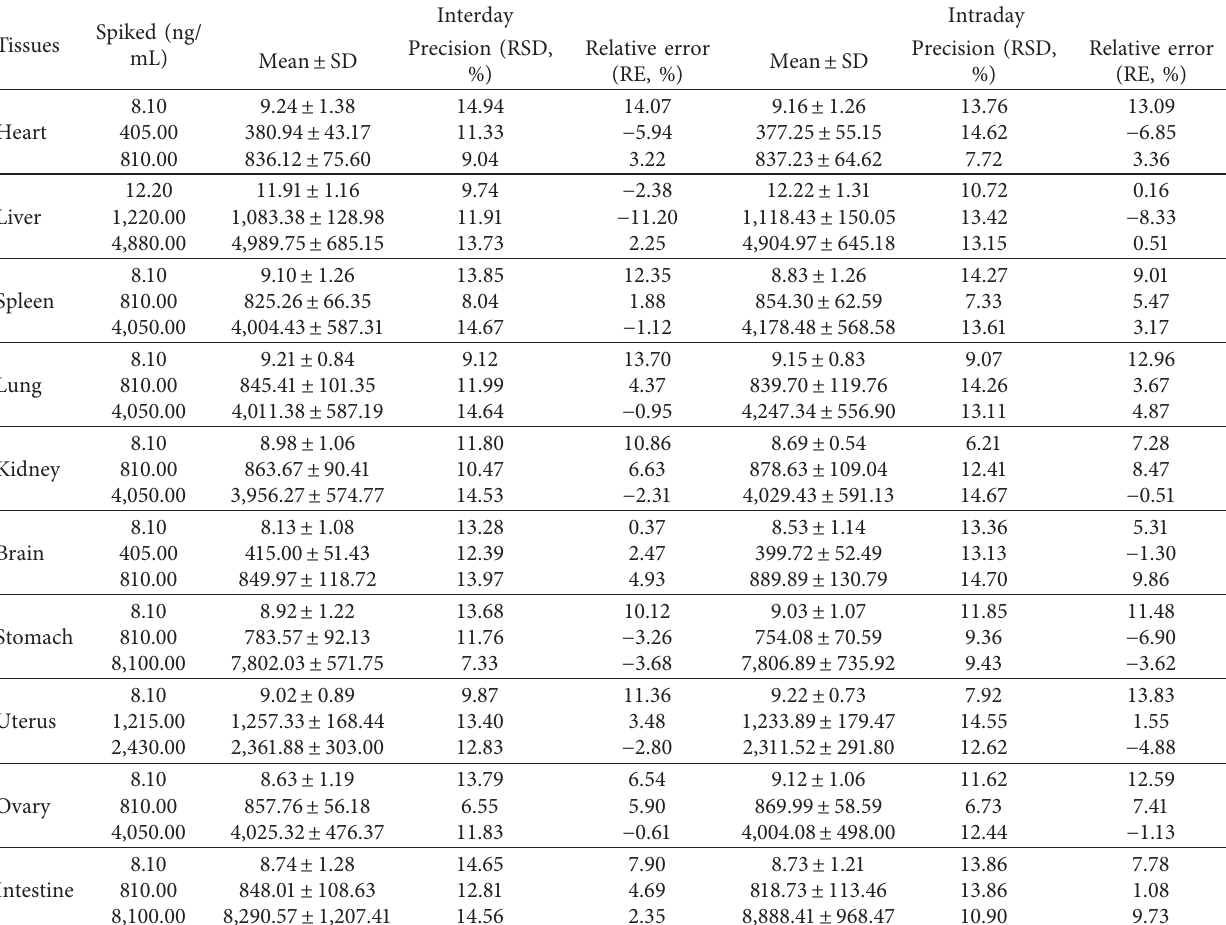
Table 6: Interday and intraday precision and accuracy data for assays of naringin in different tissues ( n � 6). Spiked (ng/ Tissues